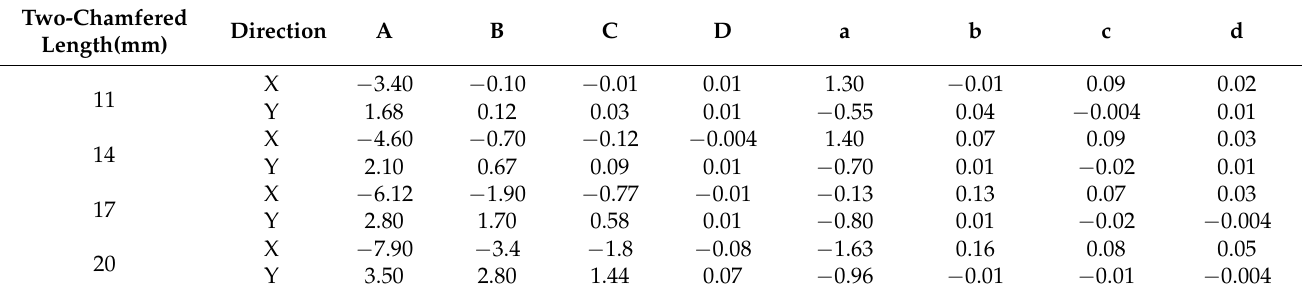
Table 3. Node deformation at different two-chamfered lengths under horizontal rolling (mm).